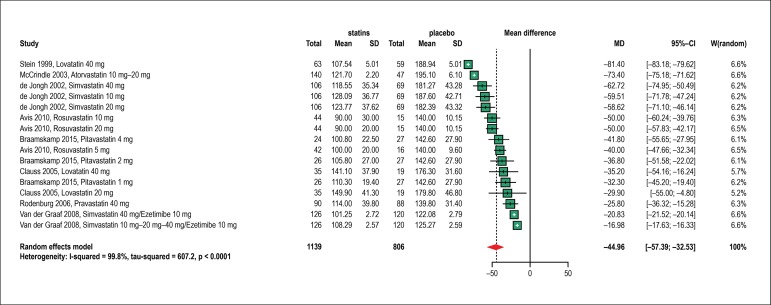
Forest plots showing the effect of statin therapy on apolipoprotein B
levels.